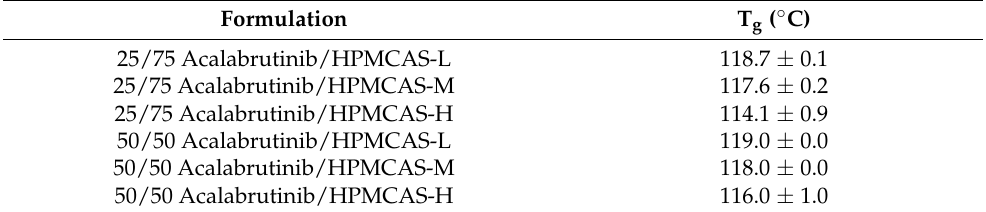
Figure A5. mDSC thermograms of manufactured acalabrutinib ASDs. Panel ( a ) 25 wt % drug loading ASDs. Panel ( b ) 50 wt % drug loading ASDs. Table A9. Glass transition temperature (T g ) values measured via mDSC for manufactured acalabruti- nib